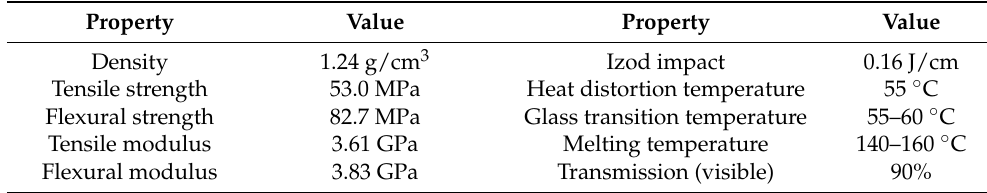
Table 1. The physical and mechanical properties of as-received PLA Ingeo 2003D pellets *. Property